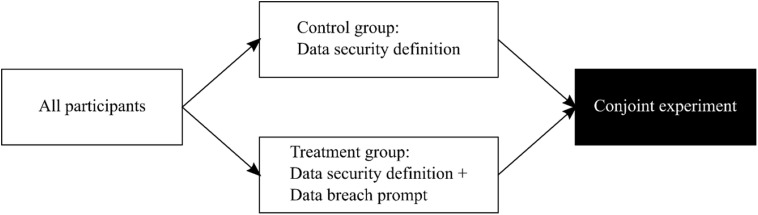
Overview of Study 1.